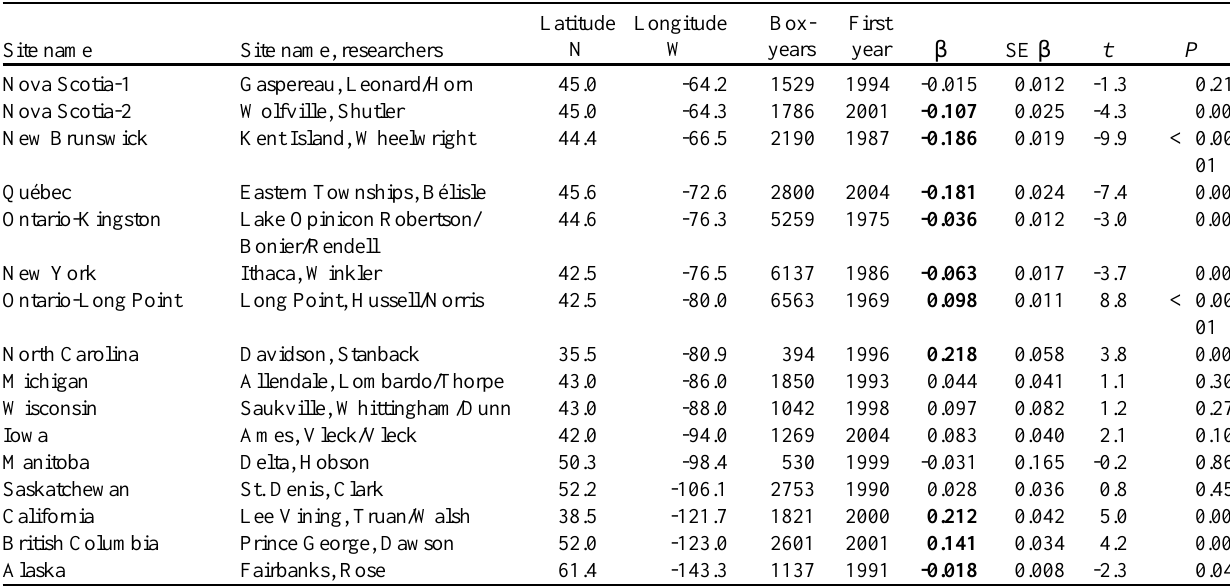
Table 1 . Site details (Fig. 1) and results of logistic regressions with number of occupied boxes and number of boxes as response variables, year as explanatory variable, and error distributions set as quasi-binomial. Sites are arranged by longitude. b is the slope, and SE b is the standard error of the slope estimate. Significant slopes in